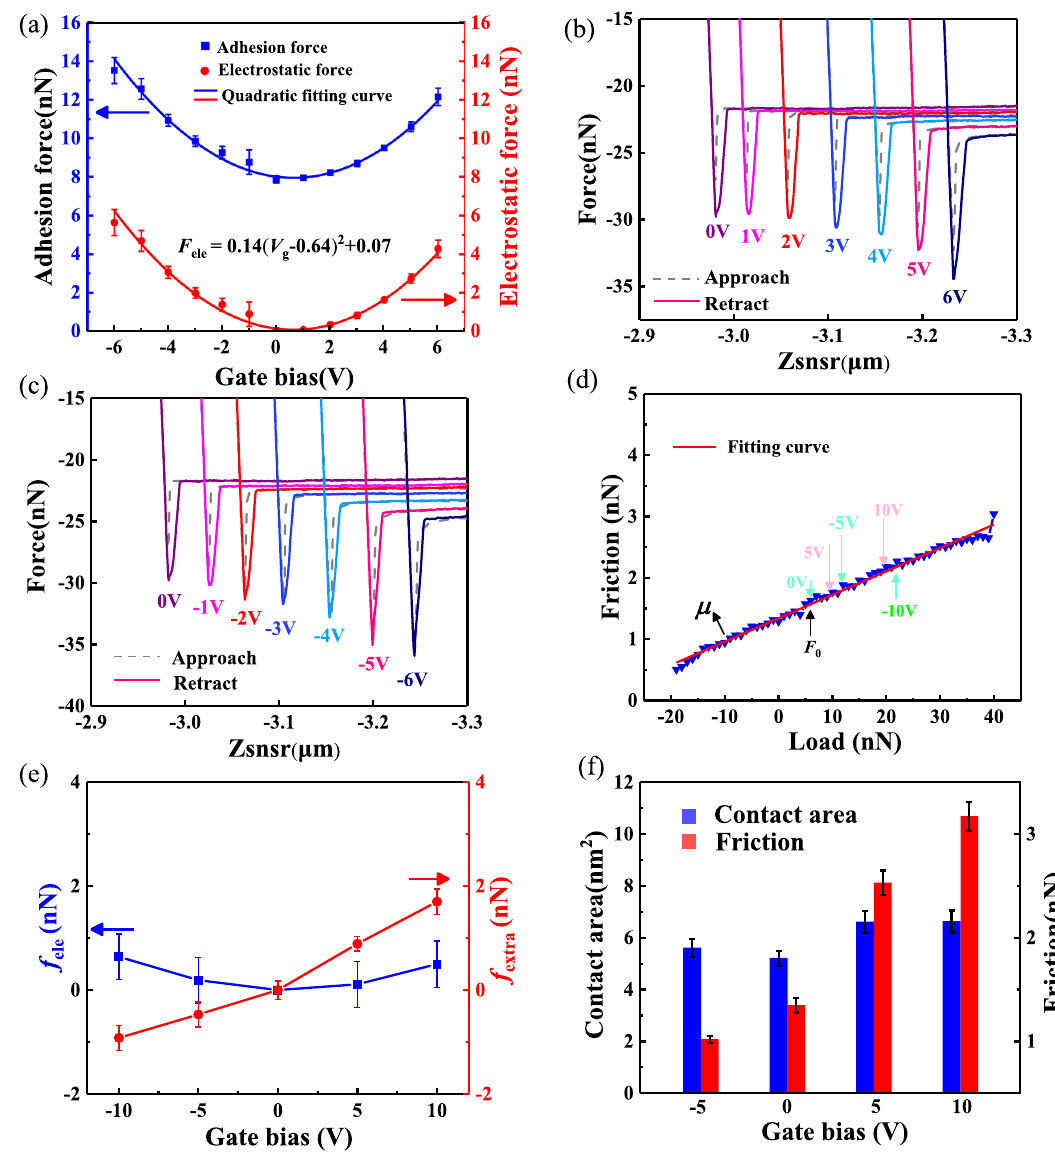
Fig. 2 Force-distance curves on atomically thin MoS 2 and variation of contact area under different V g . a Adhesion and electrostatic force as a function of V g . b Typical force-distance curves measured under the positive V g . c Typical force-distance curves measured under the negative V g . d Plots of the friction force versus the applied load on atomically thin MoS 2 at V g = 0 V. e The nanofriction caused by electrostatic force ( f ele ) and additional effect ( f extra ). f Variation of the true contact area during AFM tip sliding on atomically thin MoS 2 under different V g . Error bars represent standard